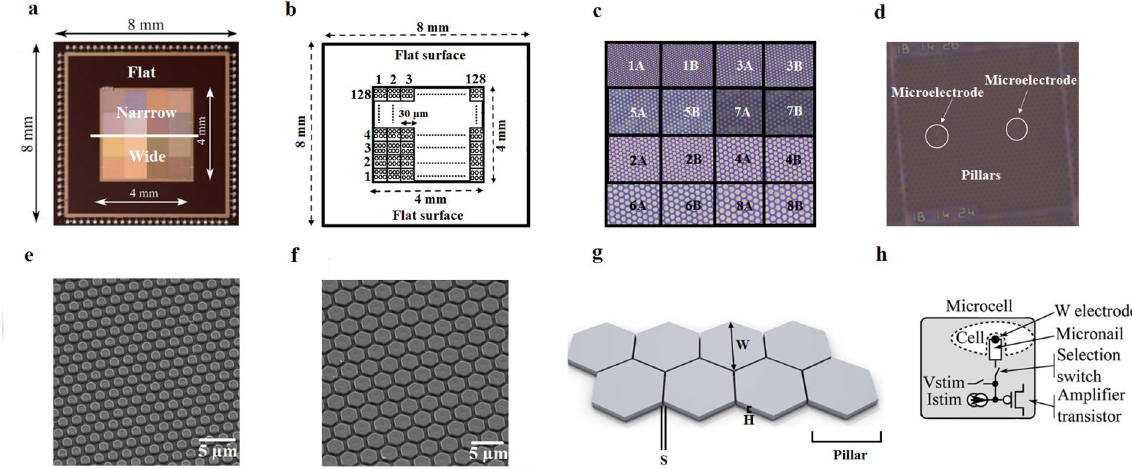
Figure 1. CMOS design. ( a ) Photograph of the CMOS chip. ( b ) Chip sketch. The large active area of CMOS chip measuring 4 by 4 mm consists of 128 × 128 addressable units called microcells. Each microcell is 30 by 30 µ m and contains a local circuit and matrix of hexagonal micro-pillars (dummy pillars) and one active TiN micro-electrode for electrical stimulation and one recording TiN micro-electrode; ( c ) Chip pillar areas with different pillar widths (white and black numbers). A and B pillars areas have the same properties, except that micro-electrodes in area A are nail-shaped and micro-electrodes in B area are flat-shaped. Odd numbers (white, 1, 3, 5 and 7) are areas with narrow pillars: area 1: 1.4 µ m; area 3: 1.6 µ m; area 5: 2 µ m and area 7: 2.4 µ m, while even numbers (black, 2, 4, 6 and 8) are areas with wide pillars: area 2: 2.8 µ m; area 4: 3.2 µ m; area 6: 4 µ m and area 8: 4.8 µ m. The height of all pillars and electrodes is 1 µ m while spacing ranges from 0.8 to 1.6 µ m (0.8, 1, 1.4 and